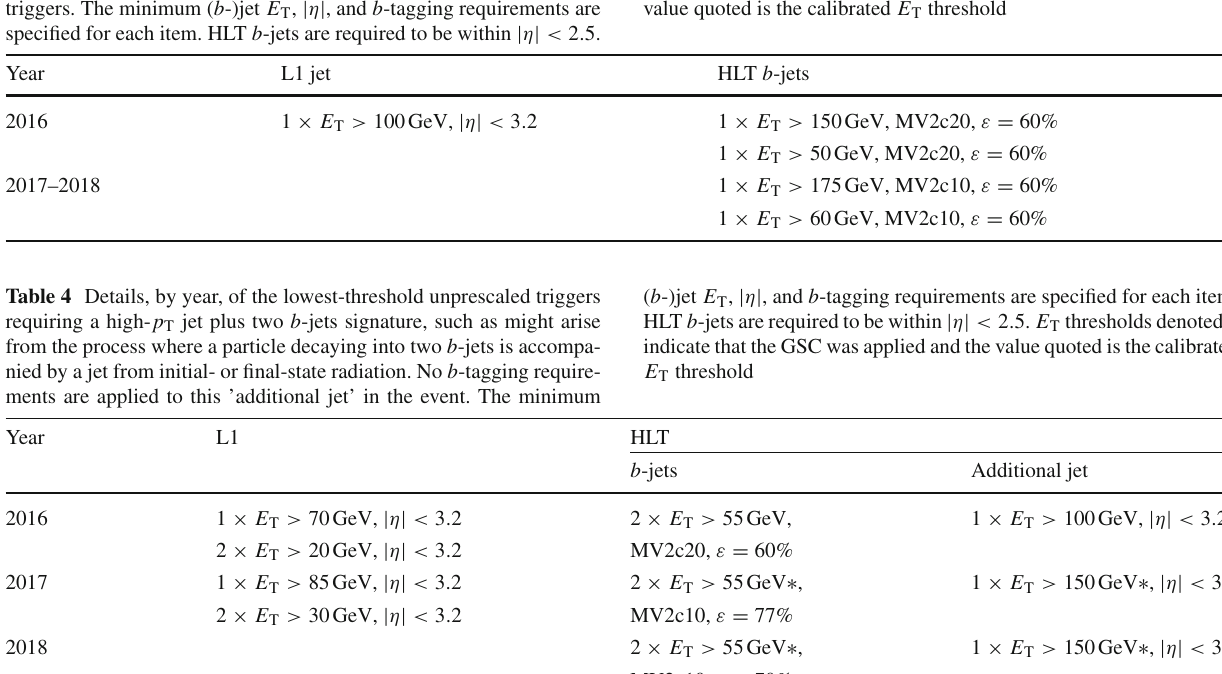
E T thresholds denoted ∗ indicate that the GSC was applied and the value quoted is the calibrated